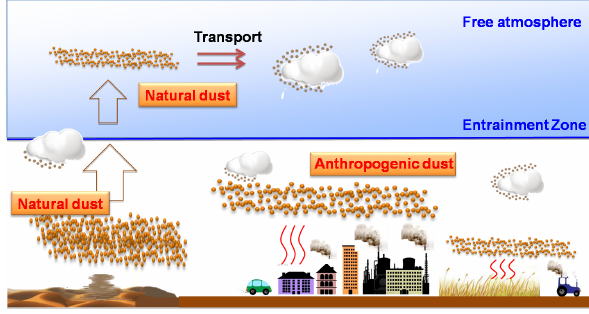
Figure 2. A schematic figure for the detection process of anthro- pogenic